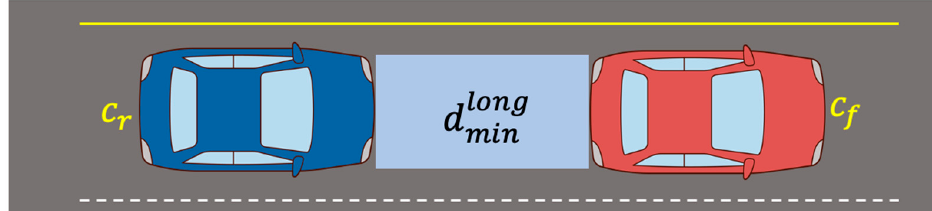
Figure 3. Longitudinal safe distance.